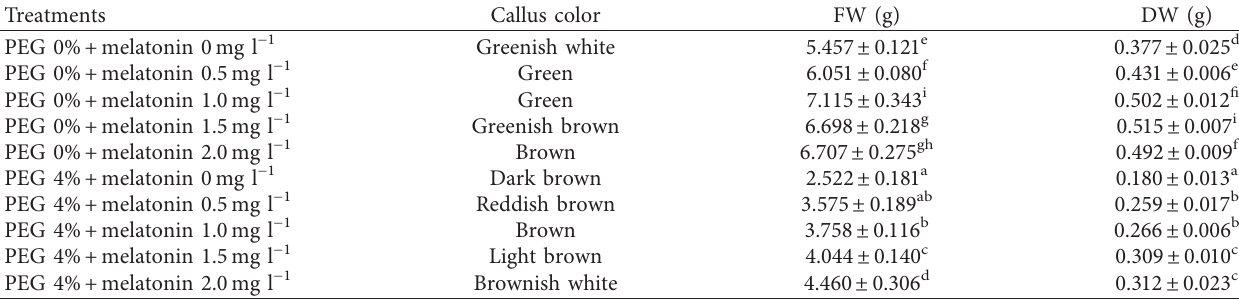
Table 1: The morphological traits, fresh weight (FW), and dry weight (DW) in H. pusillus calli cultures treated with melatonin con- centrations and PEG levels after 28 days.